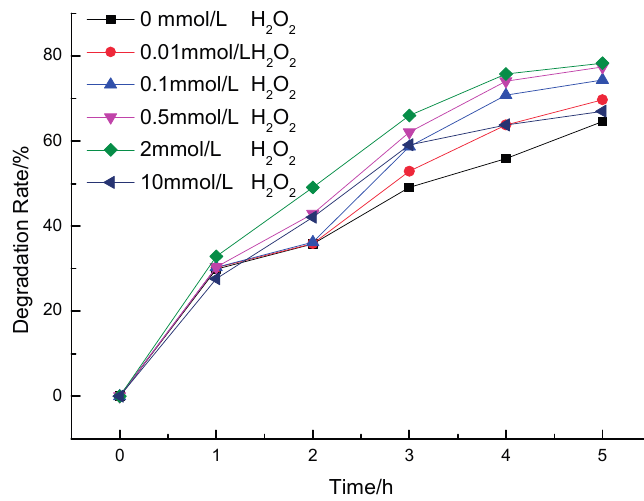
Figure 6. The effect of H 2 O 2 on the degradation of NH 4+ -N with La/Fe/TiO 2 .